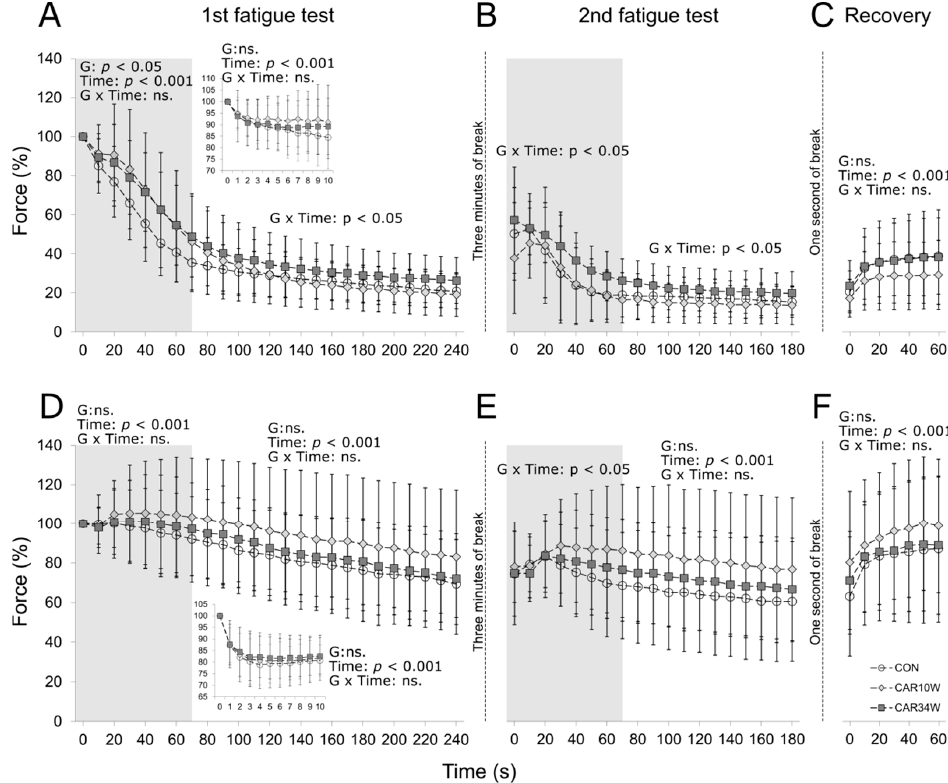
Figure 2. Effects of carnosine supplementation on the mean peak relative forces of unfused 40-Hz tetani during applied stimulation of FF and FR MUs. Peak forces were presented every 10 s and expressed as percentage of the peak force of the first tetanus (100%) generated at the beginning of the first fatigue test. The inset panels in A and D present forces generated every second during the first 10 s of stimulation. Panels ( A – C ) represent the force profiles of FF MUs and panels ( D – F ) represent the force profiles of FR MUs during the first and second fatigue tests and the recovery periods. Theoretically, the grey zone represents the dominant source of energy production from glycolysis and the white zone that from mitochondrial respiration, while the inset panels represent that from phosphagen systems (see Section 2 for explanation). CON refers to the non ‐ supplemented group, CAR10W to the 10 weeks ‐ supplemented group, and CAR34W to the 34 weeks ‐ supplemented group.